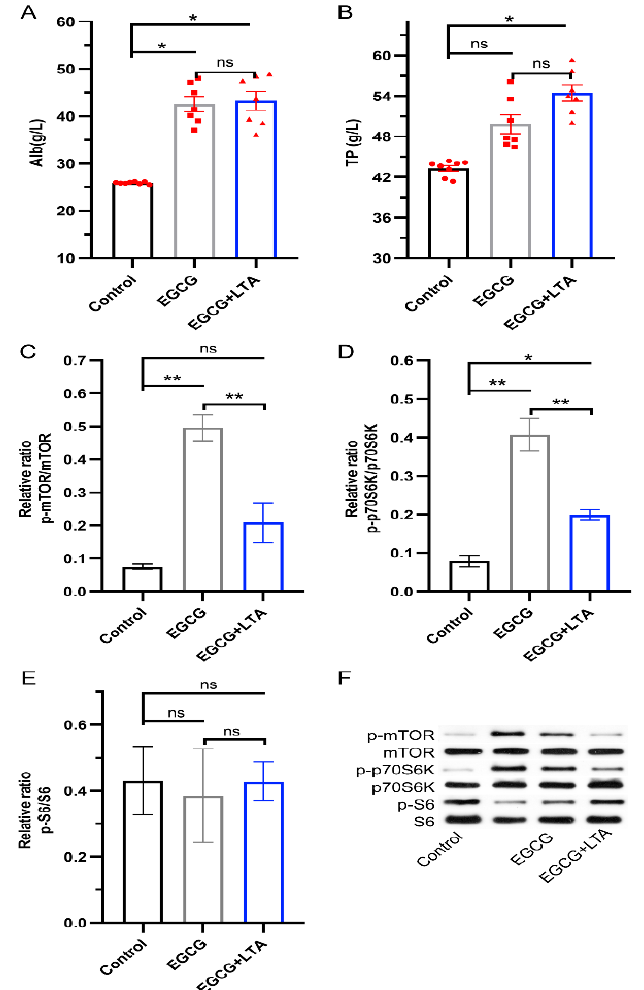
Figure 4. Protein synthesis promoted by EGCG was weakened by LTA. Serum Alb ( A ) and TP ( B ) contents in different groups. Phosphorylation levels of mTOR ( C ), p70S6K ( D ), and S6 ( E ) in rat livers ( F ). Data are expressed as the mean ± SE. * p < 0.05 and ** p < 0.01. ns: no significant difference.